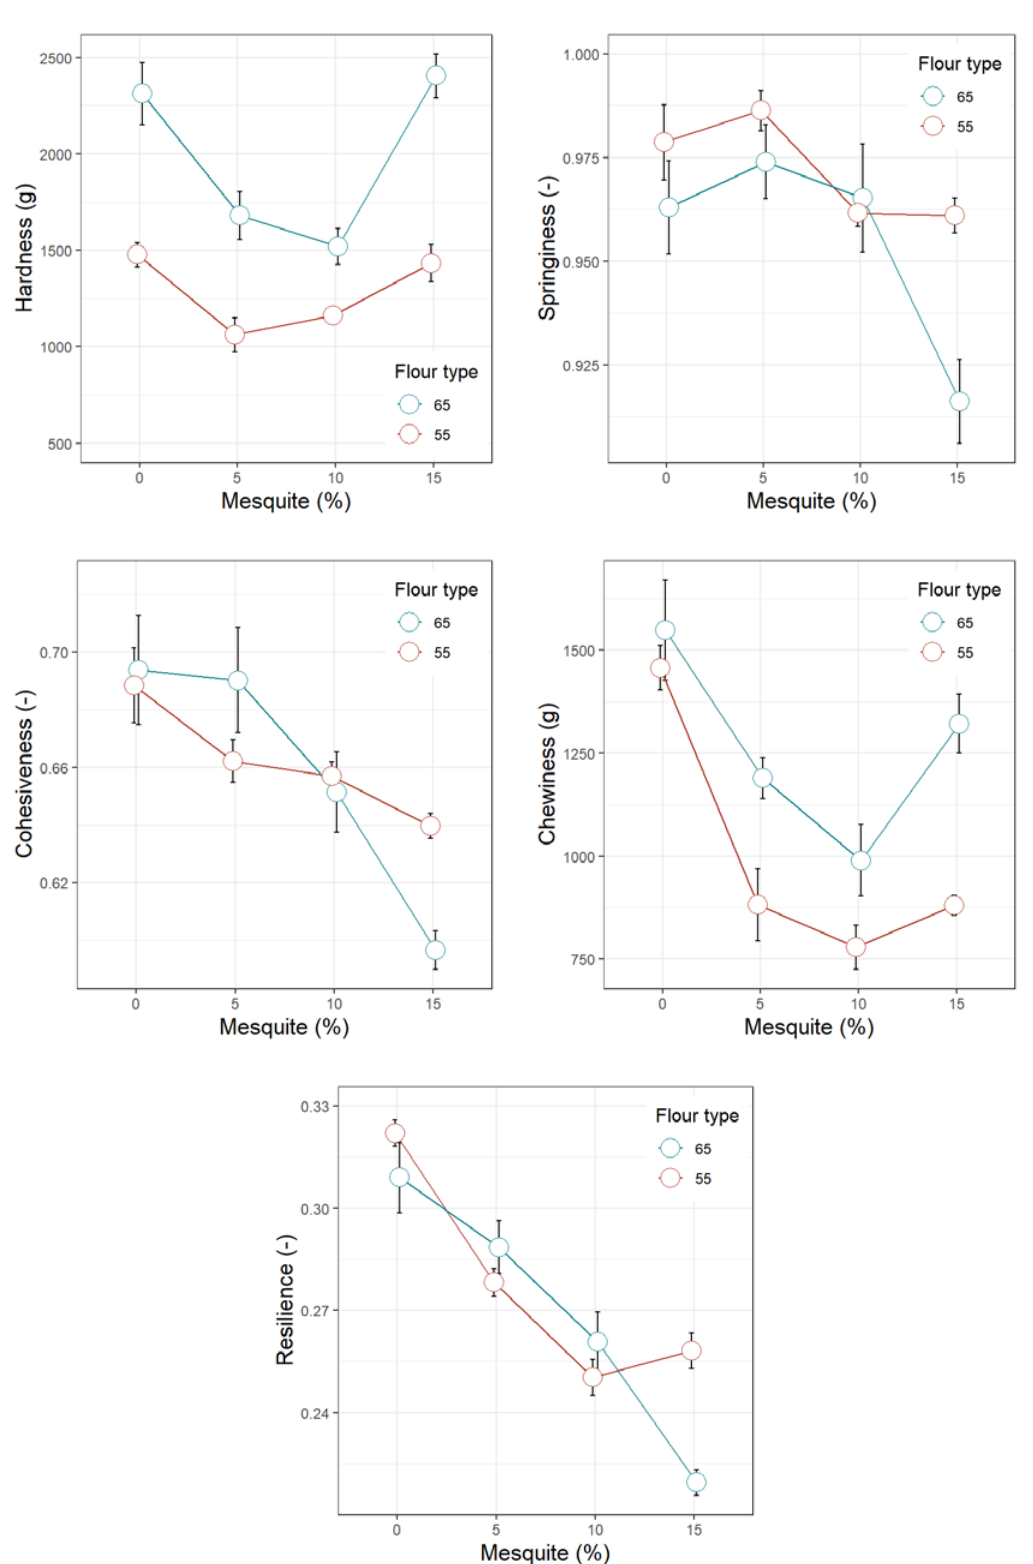
Figure 4. Crumb texture profile analysis features of bread made of wheat flour type 65 or 55 partially replaced with mesquite pod flour.